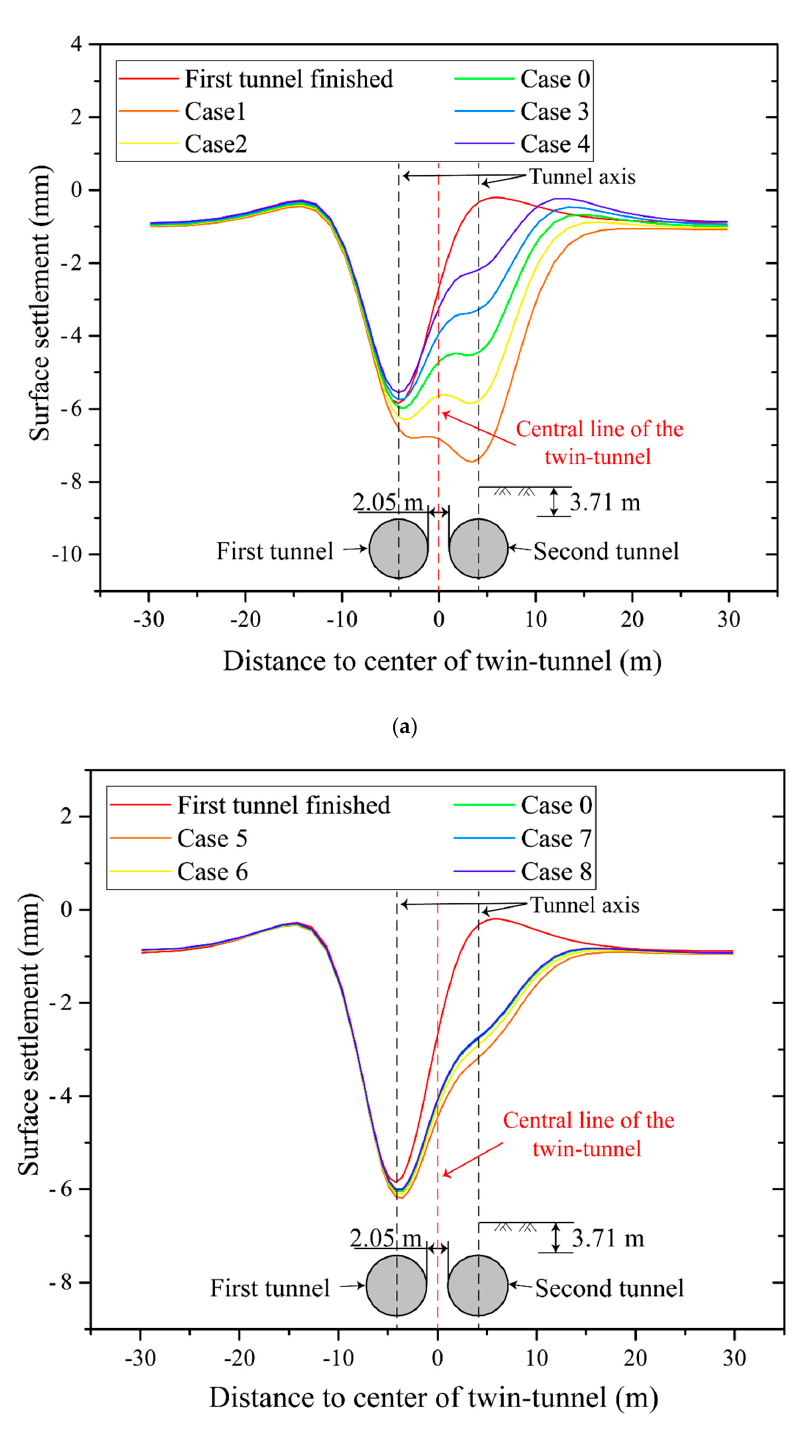
Figure 9. Surface settlement: ( a ) the cases with different grouting pressures; ( b ) the cases with different face supporting pressures. face supporting